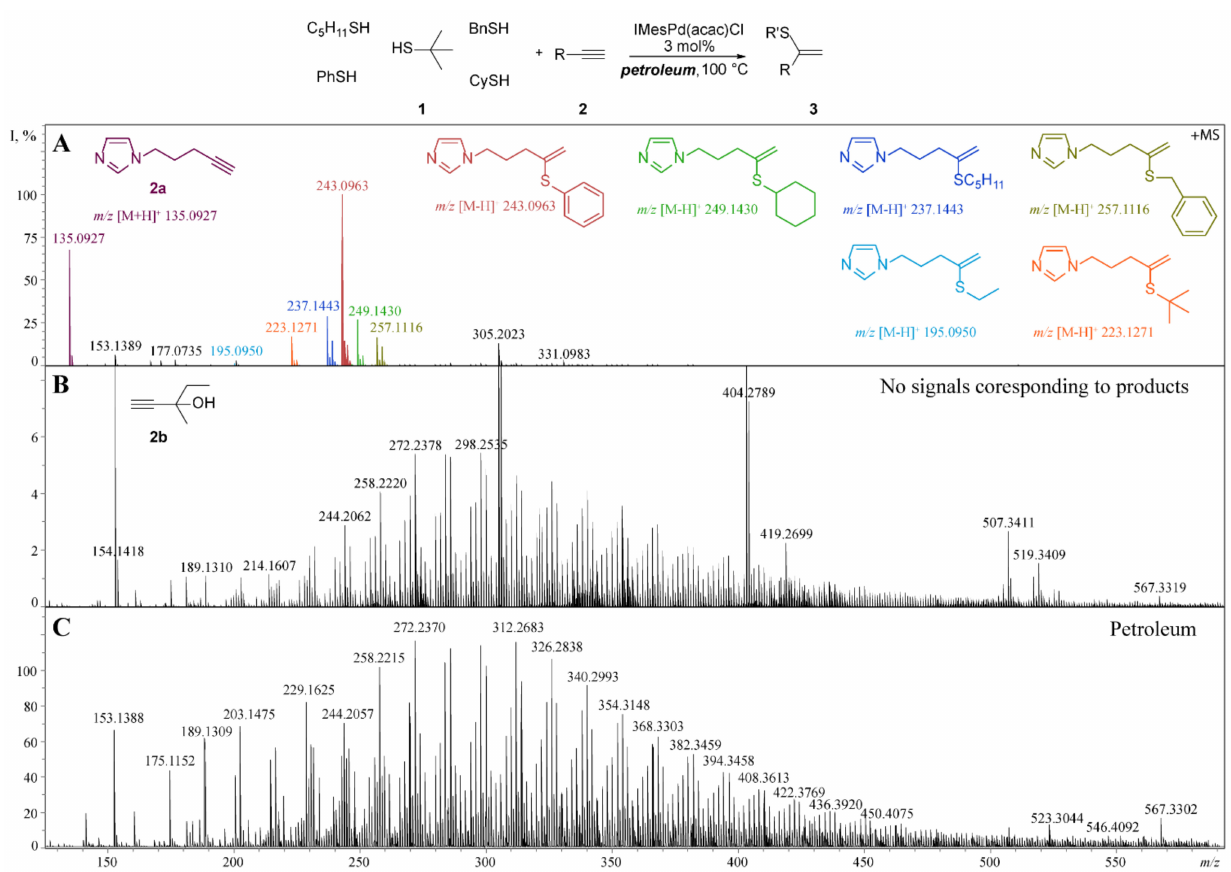
Figure 3. Comparison of the ionization level of reaction products 3 in the hydrothiolation process, which involved “electrospray tuned” alkyne 2a ( A ) and in reaction with alkyne 2b without ESI tag ( B ) carried out in the petroleum medium. The spectrum of pure petroleum is demonstrated for comparison ( C ). The ESI-(+MS) spectra were recorded in positive ion mode in acetonitrile